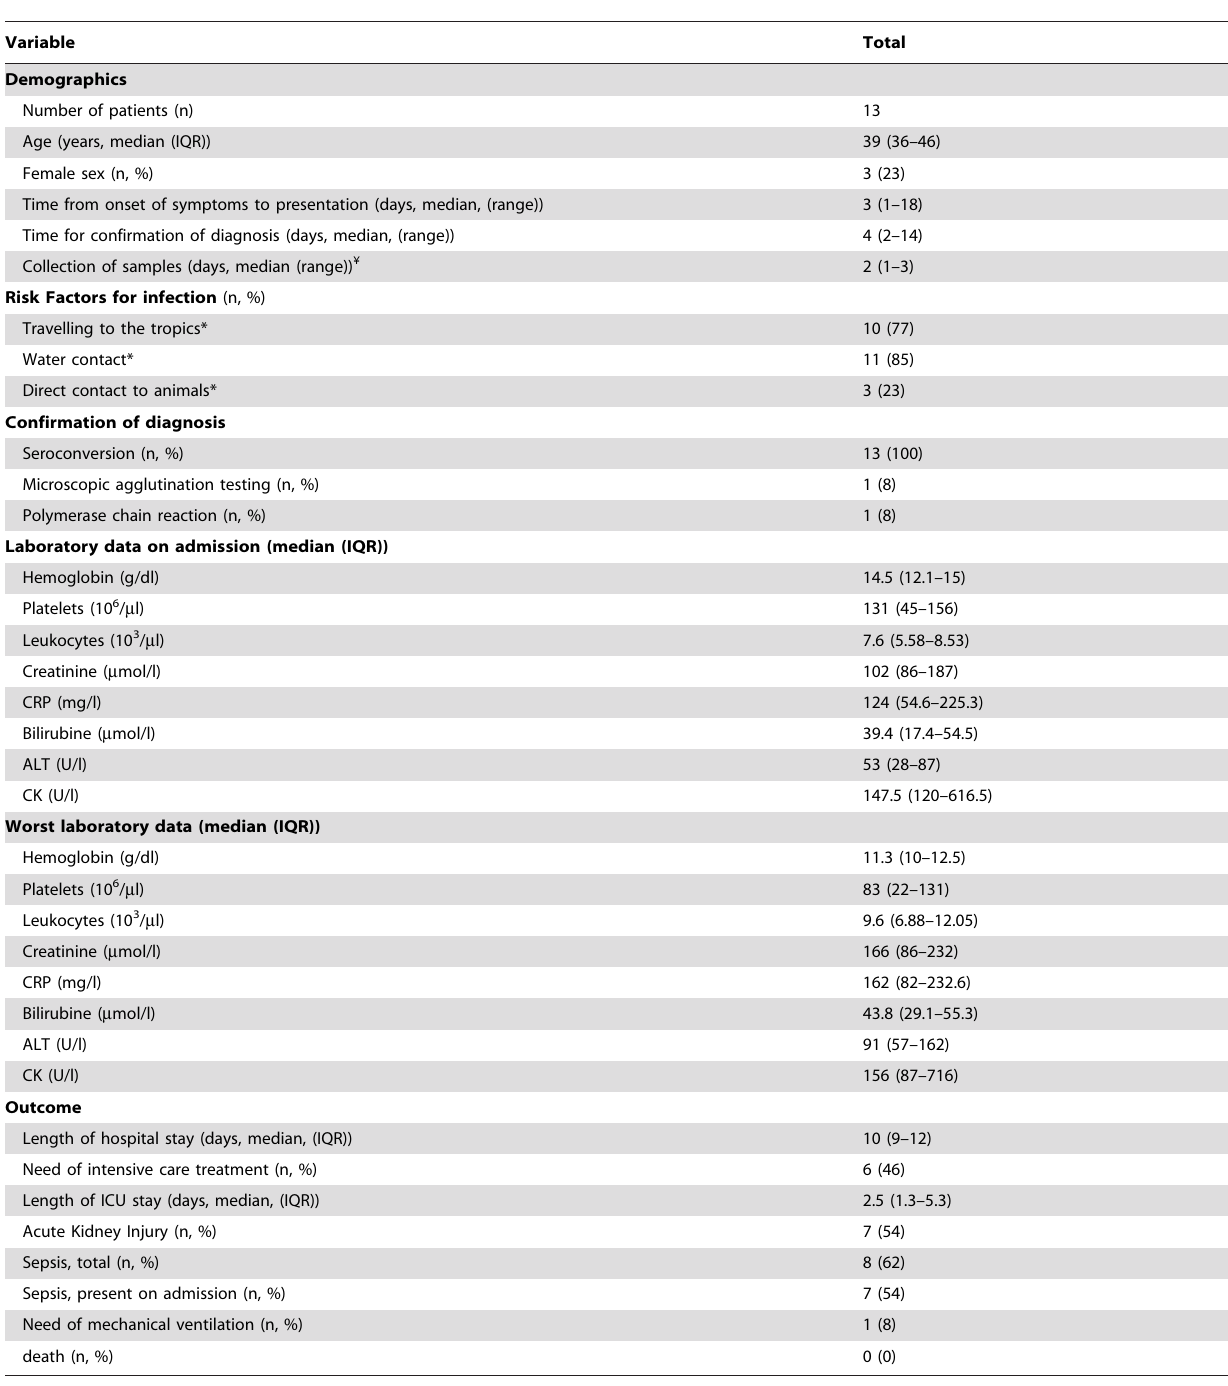
Table 1. Demographic, clinical and laboratory characteristics and outcomes of